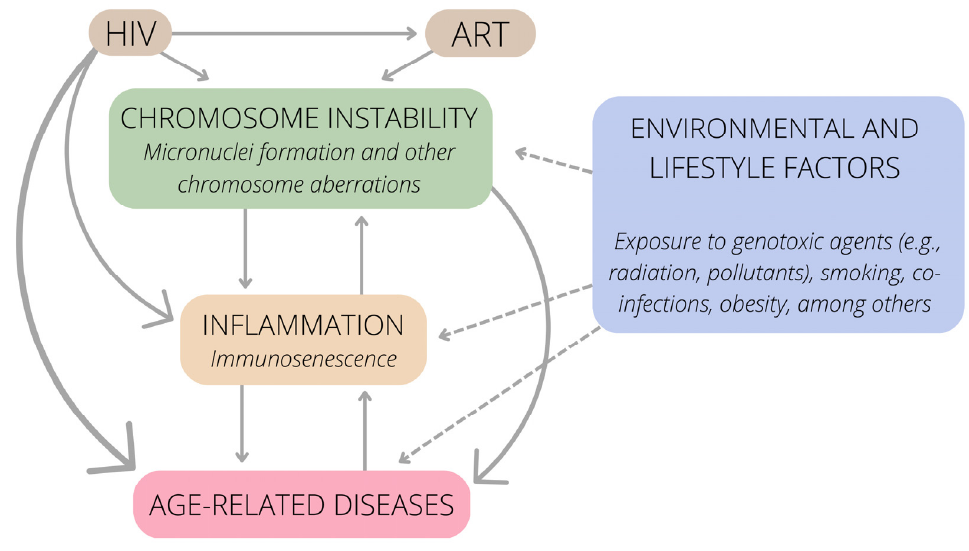
Figure 2. Connections between HIV infection, chromosome instability, inflammation, and age-related diseases.